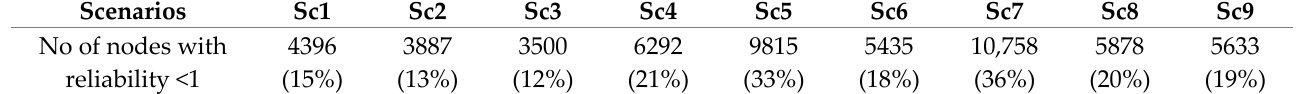
Figure 3. Probability that the chlorine reliability indicator will be ≤ x for different water conservation scenarios considering all nodes, Y -axis is cut at 0.4 for better visualization. The number and fraction of nodes with a chlorine reliability of less than one are included in the table.